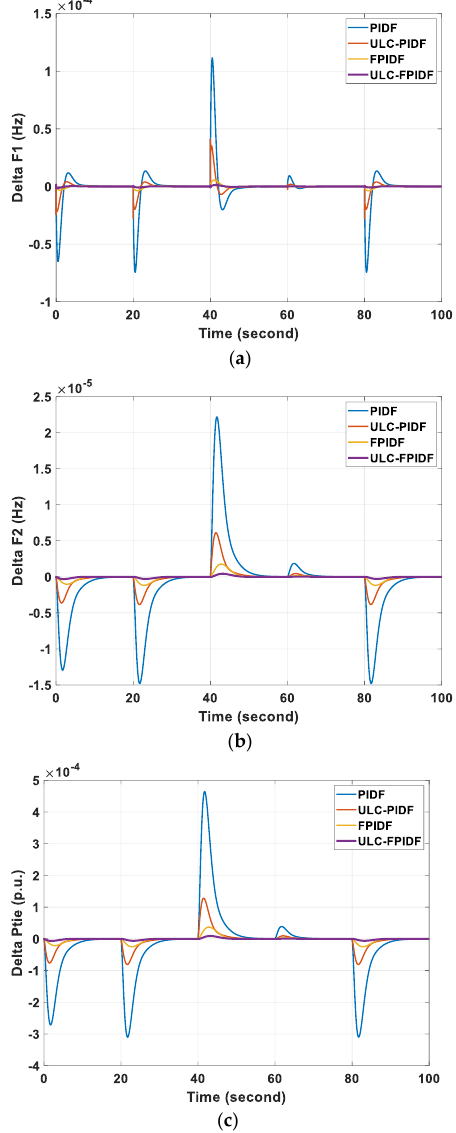
Figure 14. Dynamic response using different controllers under random load variation: ( a ) ΔF 1 , ( b ) Figure 14. Transient response using different controllers under random load variation: ( a ) ∆ F 1 , ΔF 2 , and ( c ) ΔP tie . ( b ) ∆ F 2 , and ( c ) ∆ P tie